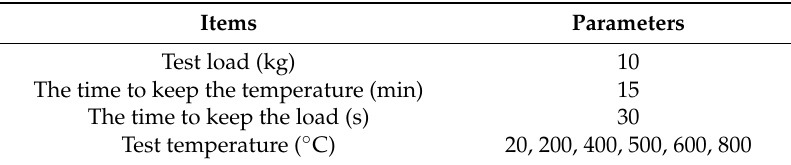
Table 3. Design of experiments for high-temperature hardness tests.